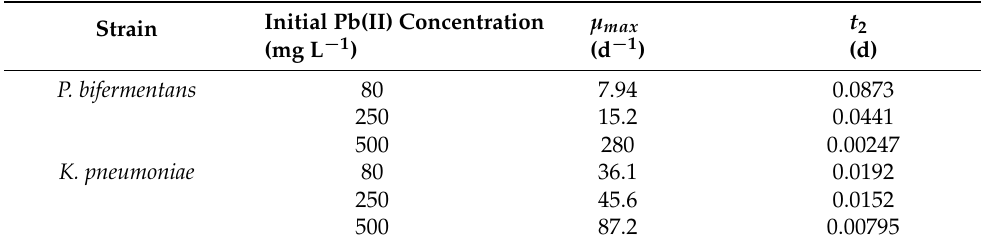
Table 1. The value of the maximum specific growth rate ( µ max ) and the generation time ( t 2 ) for all the experimental conditions observed for both